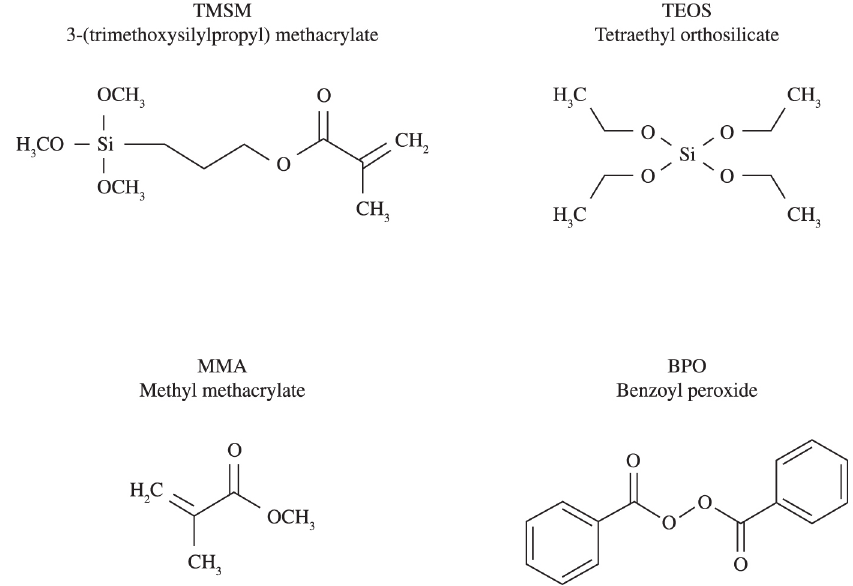
Figure 1. Structural formulas of the materials utilized in this